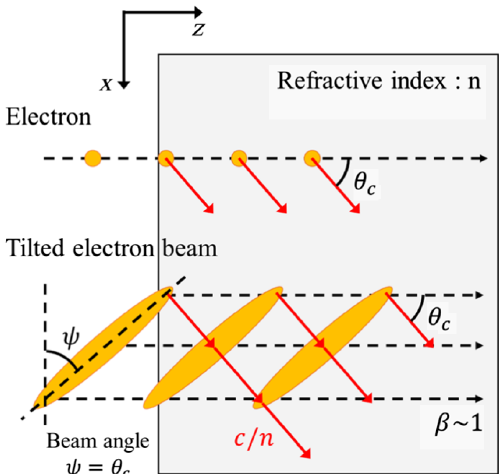
FIG. 2. Phase-matching principle using the tilted electron beam. The Cherenkov radiation generated at each point of the electron beam trajectory can be overlapped by matching the Cherenkov angle with the electron beam tilt